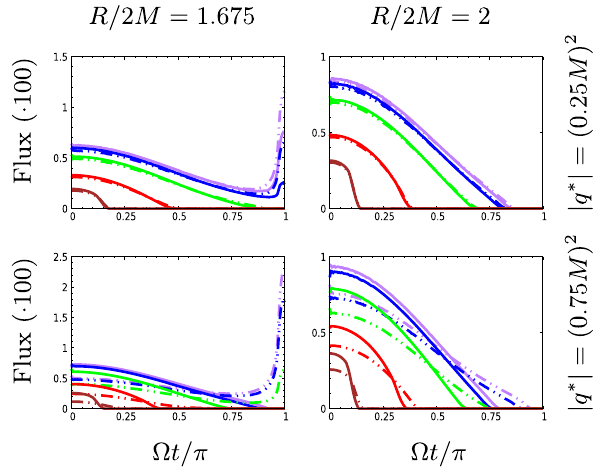
Fig. 25 Pulseprofileforsinglecaps. h = 2, ξ = χ = π/ 2.Thepurple, blue, green, green, red, and brown lines correspond to (cid:11) = 0 . 00, 0 . 30, 0 . 60, 0 . 90 and 0 . 99 respectively. The solid lines correspond to q ∗ > 0 while the dashed lines correspond to q ∗ <